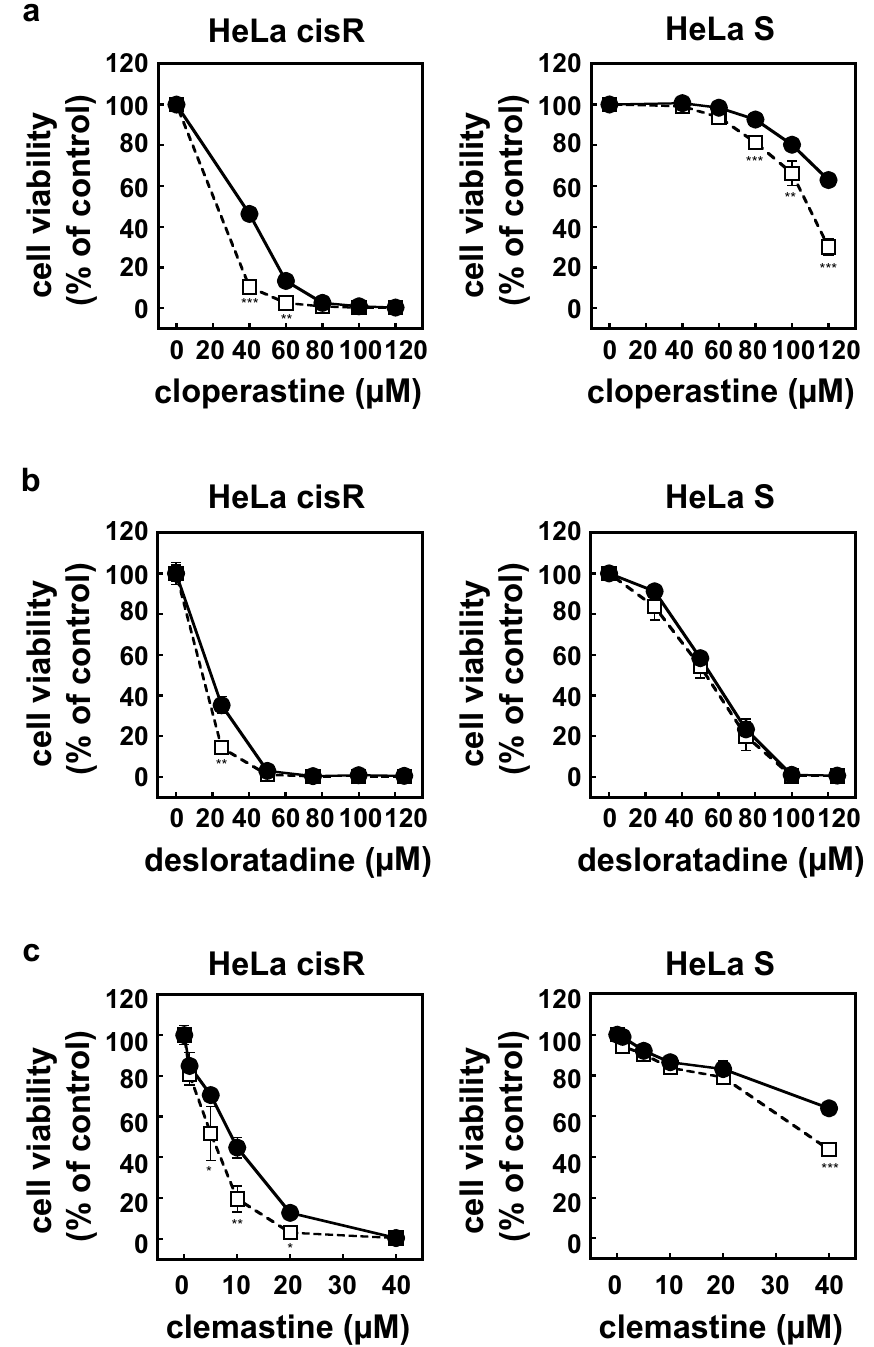
Figure 9. Weak enhancement of the cytotoxicity of H1 receptor antagonists by verapamil is not selective for HeLa cisR or HeLa S cells. HeLa cisR and HeLa S cells were cultured for 3 days with cloperastine ( a ), desloratadine ( b ), or clemastine ( c ) in the absence (filled circles) or presence (open squares) of 50 µM verapamil. Cell viability during the final 5 h of the culture was evaluated in WST-8 colorimetric assays. The results are presented as means ± S.D. of quadruplicate samples. Three separate experiments yielded essentially the same results. The significance of the difference between the results from control cells and verapamil-treated cells at the same concentration of the indicated compound was determined with ANOVA (***p < 0.001; **p < 0.01; *p <